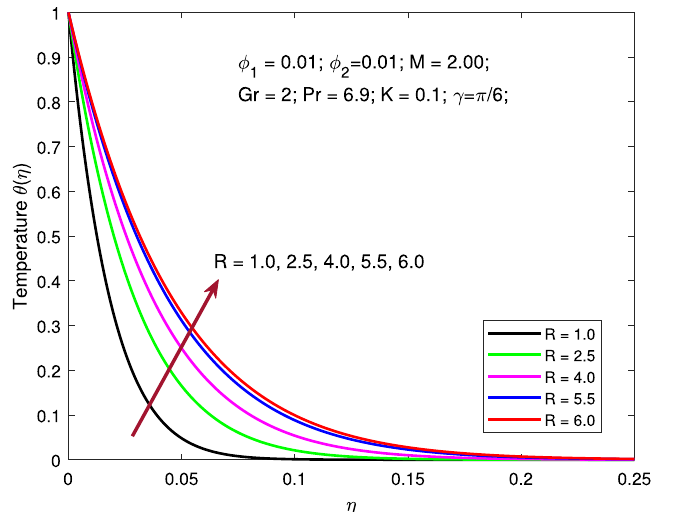
Figure 9. Variation of temperature with thermal radiation.